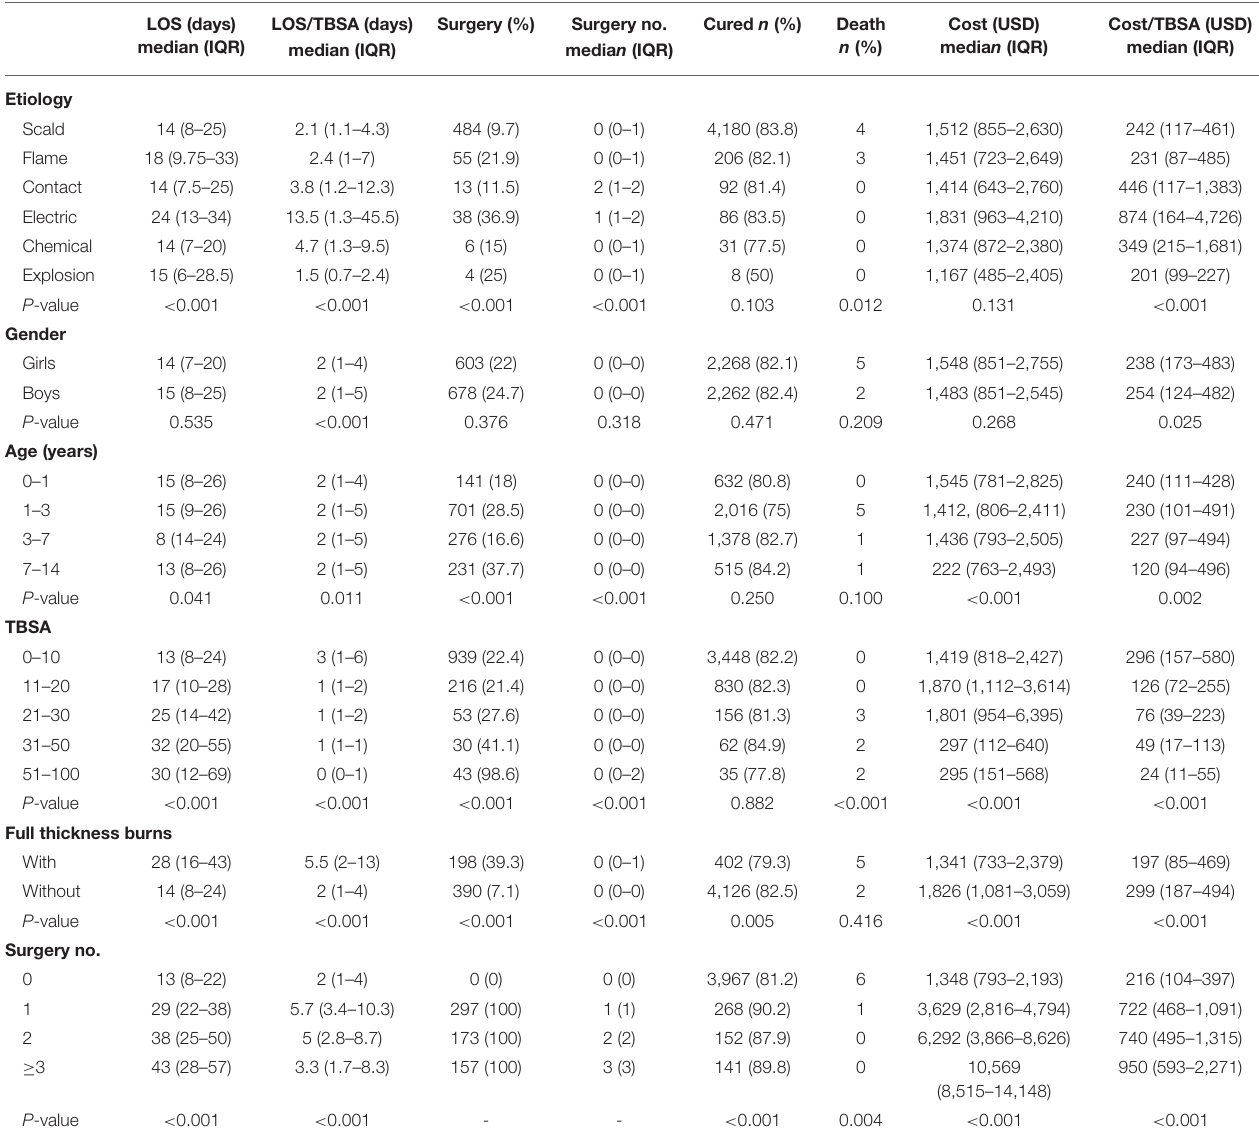
TABLE 2 | Distribution of factors related to